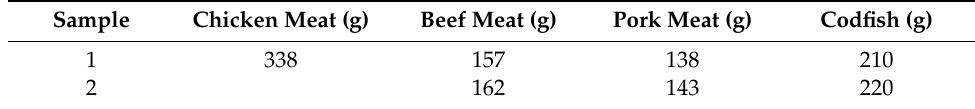
Table 4. Mass of samples of di ff erent foods, employed as a test set for PCA models.